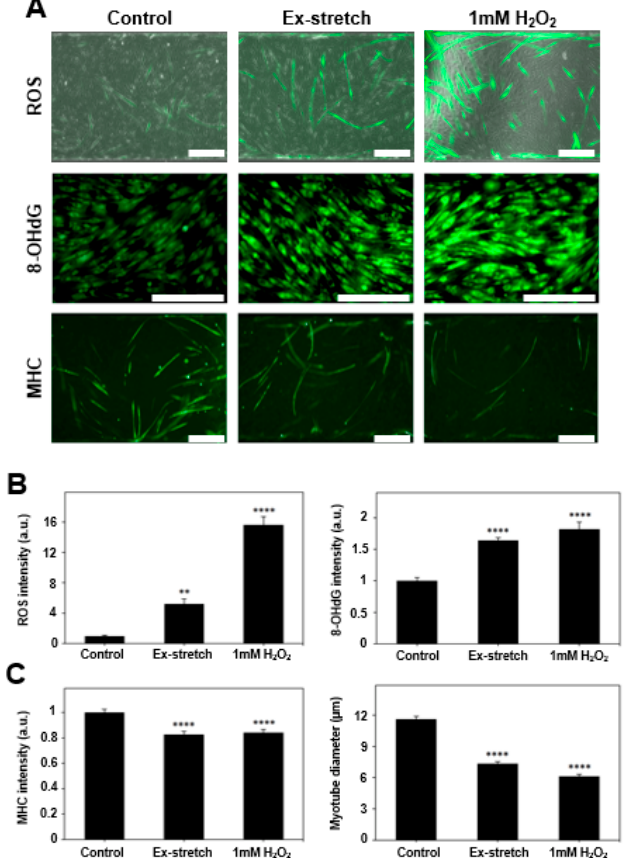
Figure 3. Confirmation of muscle cell damage. ( a ) Muscle cells are damaged with excessive stretch or H 2 O 2 as shown with merged images of phase contrast and reactive oxygen species (ROS) fluorescent image, immunofluorescence images of 8-OHdG, and MHC. Control indicates the condition before damage (scale bar: 200 µ m). ( b ) Increased fluorescent intensity of ROS ( n > 54), 8-OHdG ( n > 485), and ( c ) decrease in MHC ( n > 173) fluorescence signals and myotube diameter confirm the muscle cell damage (all bars represent standard error mean. No star for p ≥ 0.05; * for p < 0.05; ** for p < 0.01; *** for p < 0.001; and **** for p < 0.0001 by one-way ANOVA for each group).